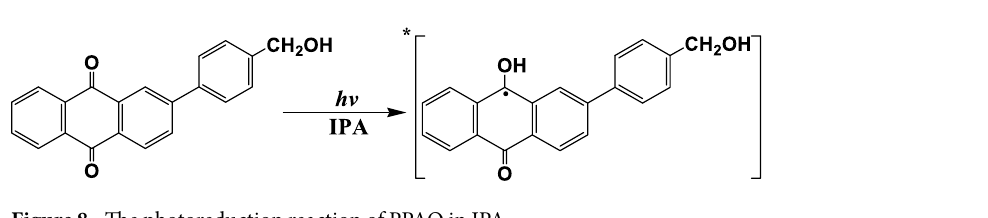
Figure 8. The photoreduction reaction of PPAQ in